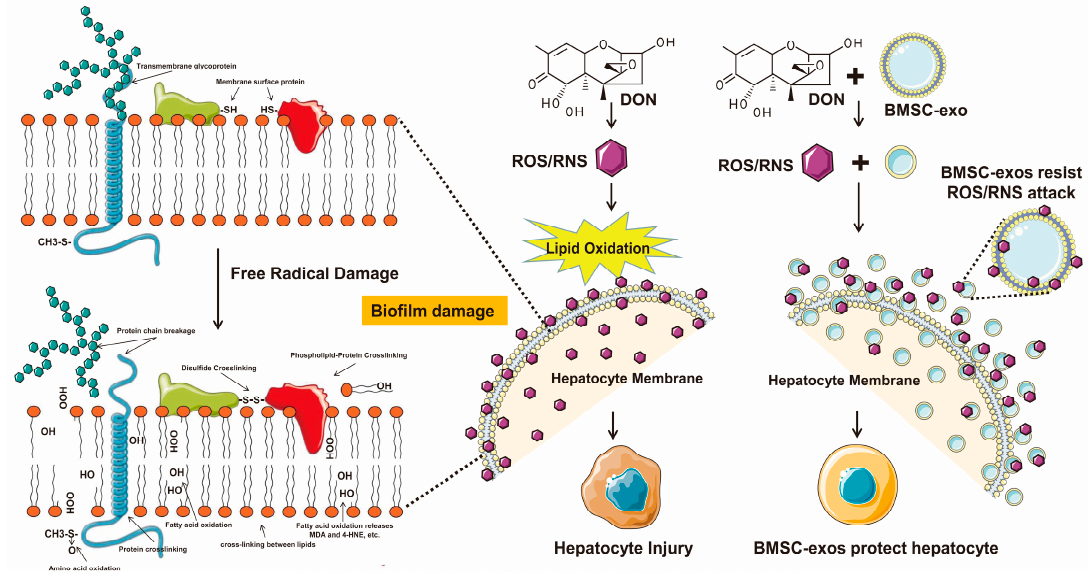
Figure 9. Mechanism mode diagram. The “main battlefield” or “first battle line” of DON-induced lipid peroxidation occurs on exosome membranes, thereby further alleviating the damage of lipid peroxidation to hepatocyte membranes and other cellular